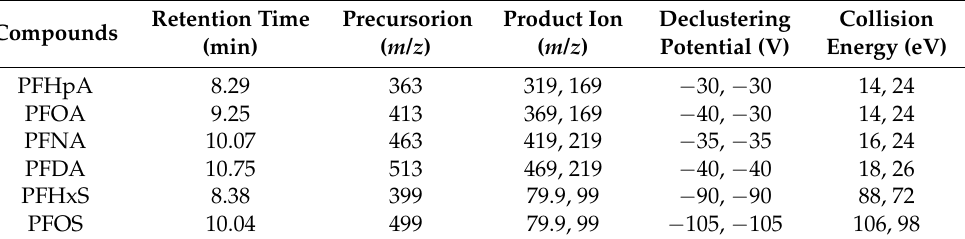
Table 4. HPLC–MS/MS parameters for MRM acquisition of